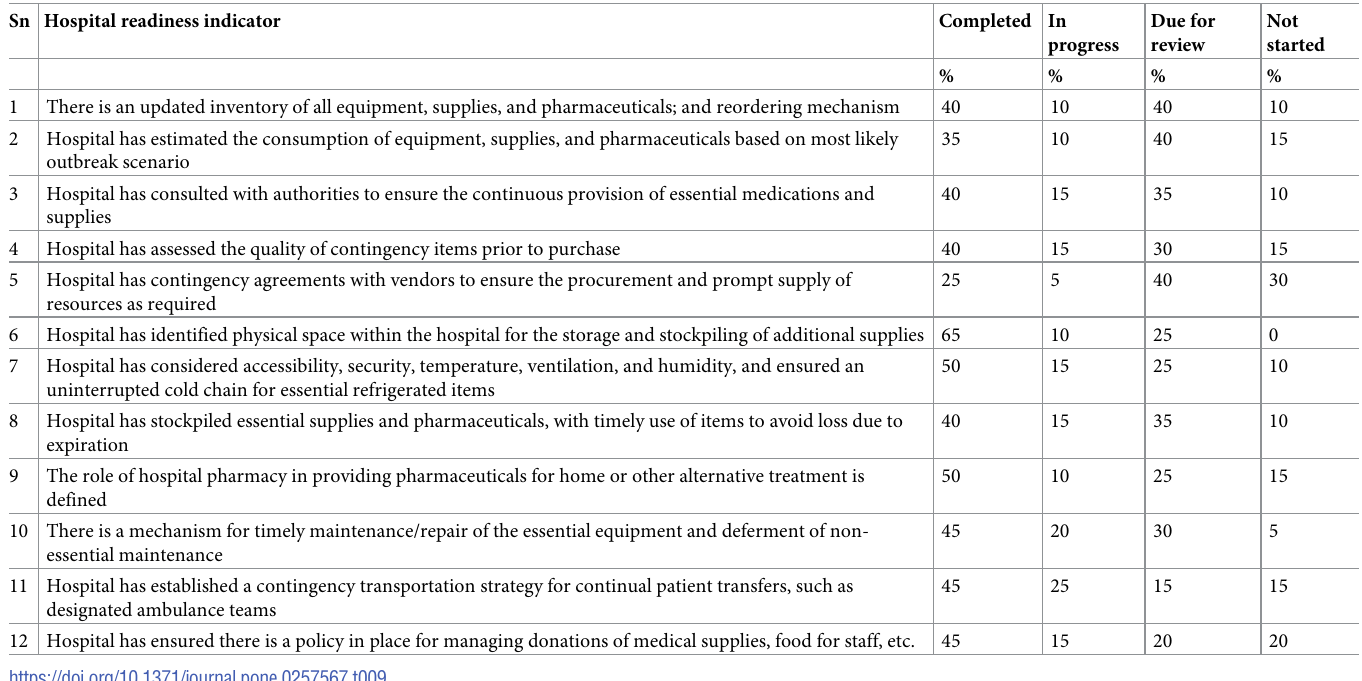
tion, confirmation, and monitoring of COVID-19 (Table 10). About 70% of hospitals had trained staff on specimen handling, packaging, and transportation procedures for specimen referrals, 50% of hospitals had established a biosafety level 2 or higher laboratory for diagnosis of infectious diseases, and 40% had the capability to test for COVID-19. Table 9. Implementation of logistic and management of supplies, including pharmaceuticals readiness indicators among 20 hospitals in Nigeria. Sn Hospital readiness